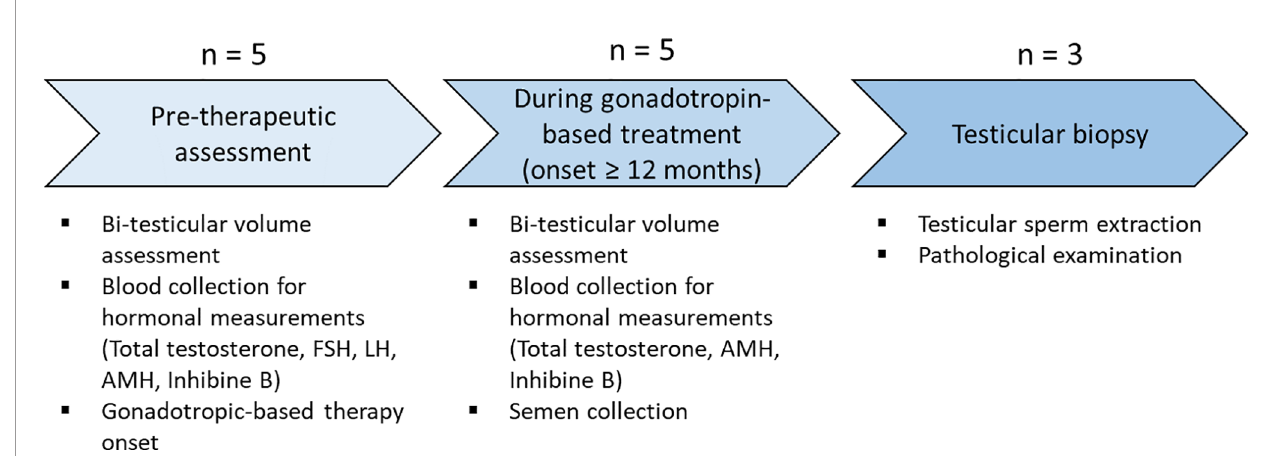
FIGURE 1 | Protocol design. Physical examination and biological samples at each step of the protocol. The number of patients undergoing each step is indicated. Each step of the protocol is represented by an arrow. AMH, anti-Müllerian hormone; FSH, follicle-stimulating hormone; LH, luteinizing